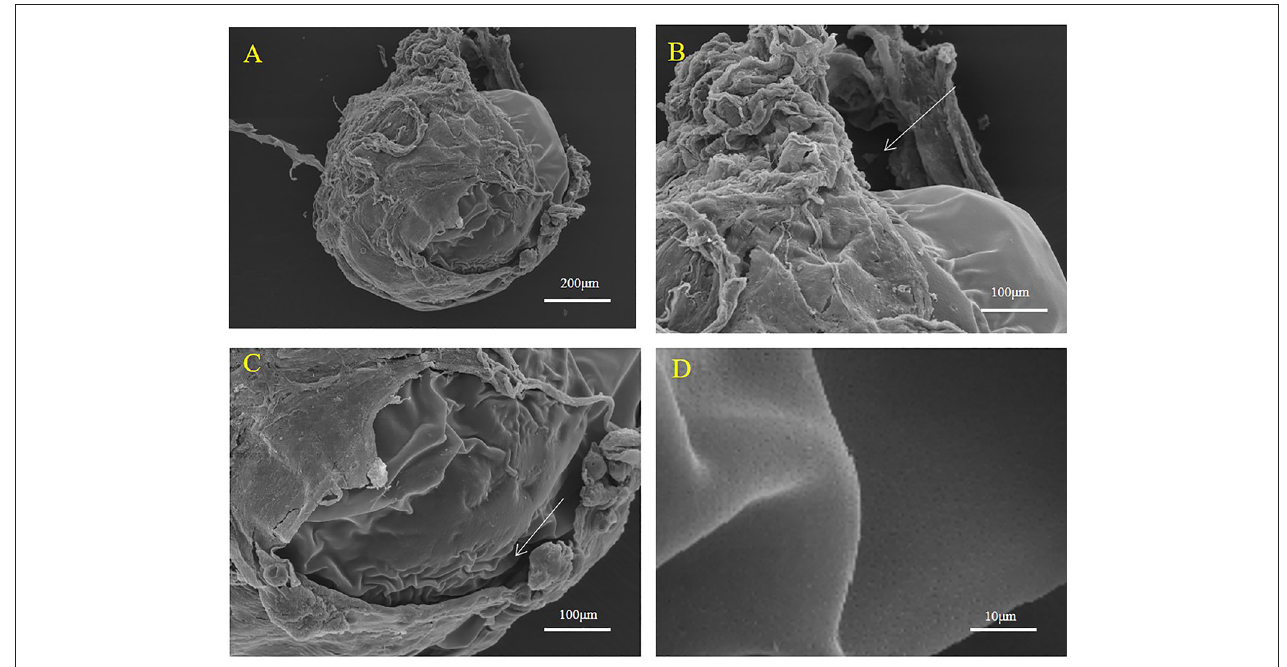
FIGURE 3 | Representative SEM images of the surface of the maternal follicle in S. schlegelii . (A) The embryo was wrapped in a follicle. (B,C) The embryo and the sac were not closely connected. (D) Many small holes existed on the surface of the thin egg membrane. The gaps were marked with arrows. Scale bars, 200 µ m (A) ; 100 µ m (B,C) ; 10 µ m (D)